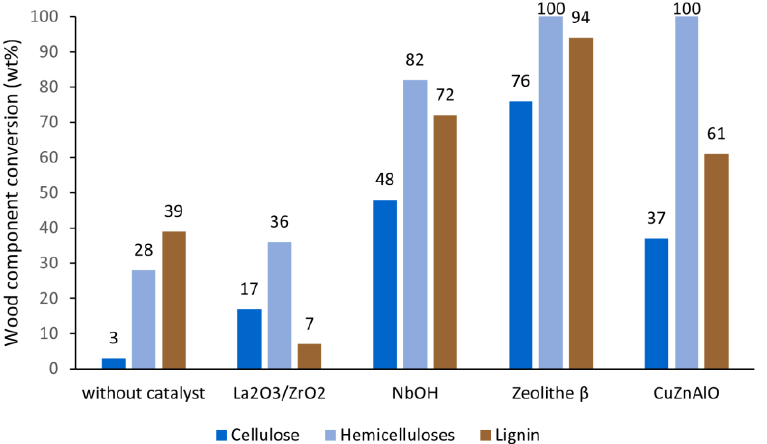
Figure 5. Conversions (wt%) of cellulose, hemicelluloses and lignin in the presence of various catalysts, in SC ethanol at 250 °C. Conditions: batch reactor, 2.5 g pine, 1 g catalyst, 27 g ethanol, 250 °C, 1 h, 80 bar.